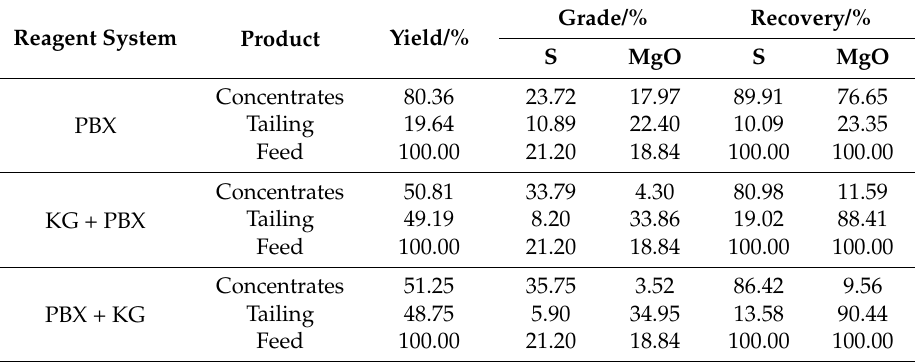
Table 2. Flotation results of artificially mixed minerals. (PBX concentration of 2 × 10 − 4